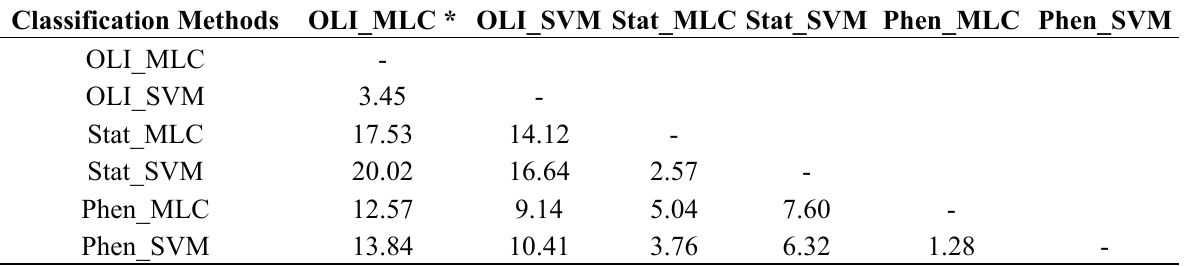
Table 3. Z-test values for comparison between confusion matrixes of land cover classification with different